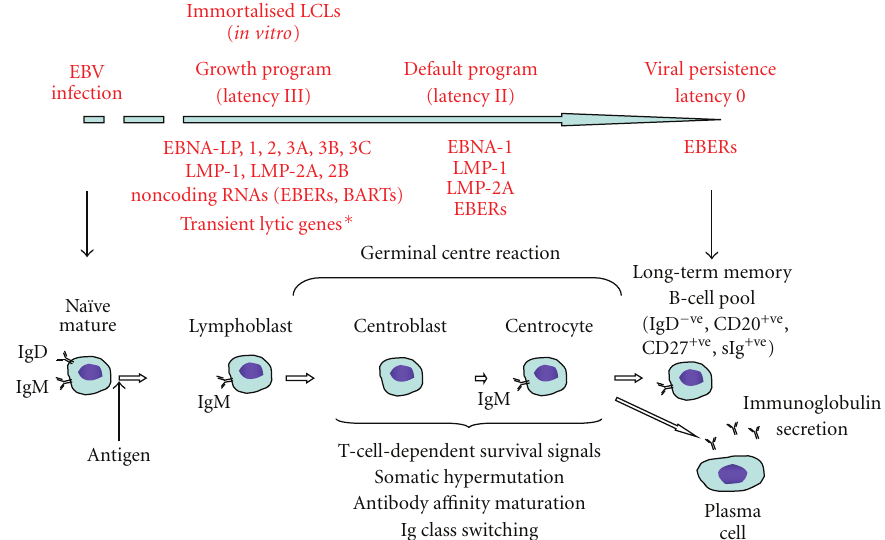
Figure 1: Model of establishment of EBV latency in B cells. EBV infects na¨ıve IgD-positive B cells and drives their proliferation by expression of the viral latency III genes, including the latent membrane proteins LMP1, LMP2A, and LMP2B, the EBV nuclear antigens EBNA1, 2, LP, 3A, 3B, and 3C and noncoding RNA species, the EBV-encoded RNAs (EBERS), and BamHI-A rightward transcripts (BARTs). In vitro , these blasts form continuously proliferating immortalised, lymphoblastoid cell lines (LCLs). EBV-infected cells participate in the GC reaction during which time the number of viral gene products expressed decreases due to the downregulation of the viral transcription factor EBNA- 2. Following di ff erentiation, long-lived memory B cells emerge as the site of persistent latent infection carrying viral episomal DNA and expressing few viral genes to avoid immune surveillance. ∗ Transient lytic gene expression may occur but without virion production.